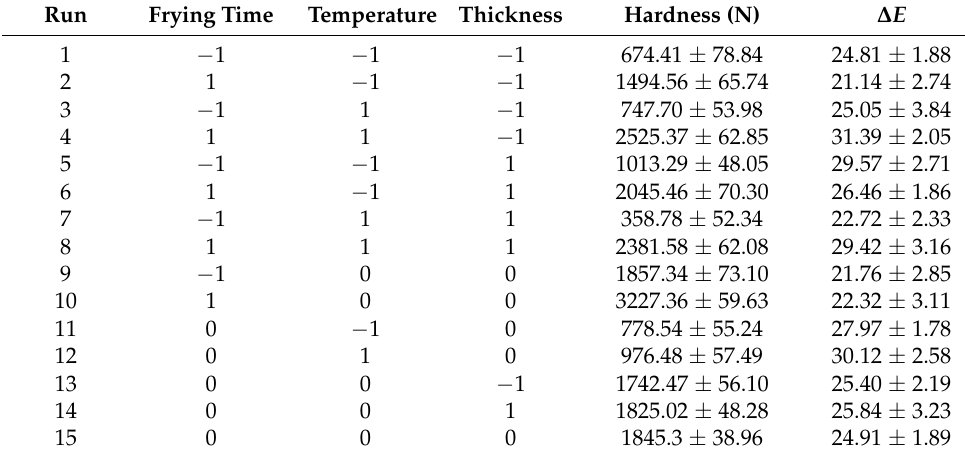
Table 2. Design and results for the central composition design. Run Frying Time